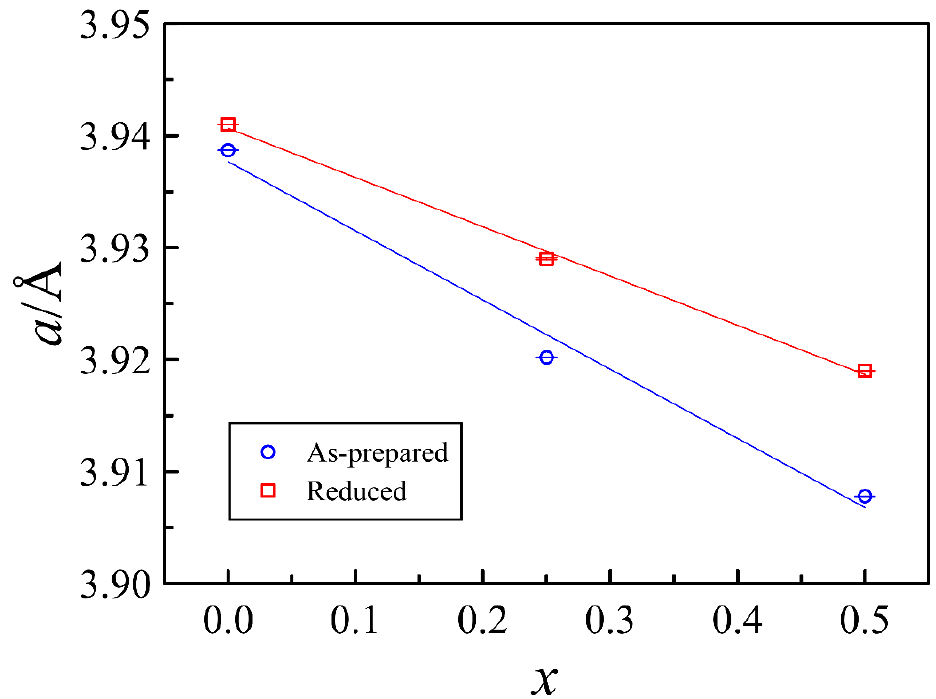
Figure 3. Unit cell parameter of PrBa 1 − x Sr x Fe 2 O 6 − δ after different thermal treatments as a function of strontium content.